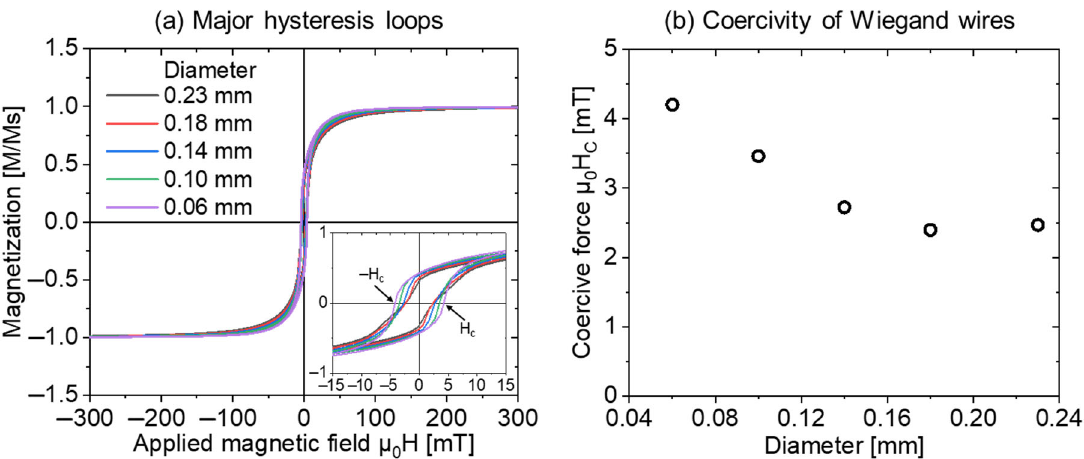
Figure 4. ( a ) Major hysteresis loops of Wiegand wires and ( b ) coercivity of Wiegand wires with varying diameters.